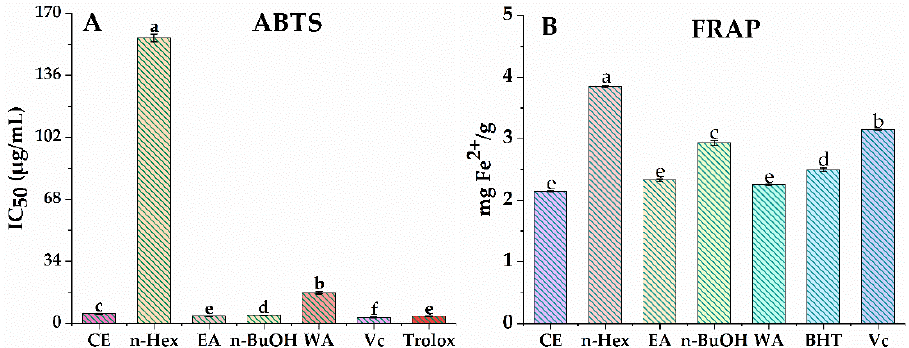
Figure 2. Antioxidant activity of CE, n-Hex, EA, n-BuOH and WA fractions of A. indica. ( A ) the IC 50 value of ABTS radical scavenging assay, ( B ) ferric-ion-reducing antioxidant power (FRAP) assay. Mean values with different letters (a–f) were significantly different at a level of p < 0.05 ( n = 3) by DMRT (Duncan’s multiple range test).